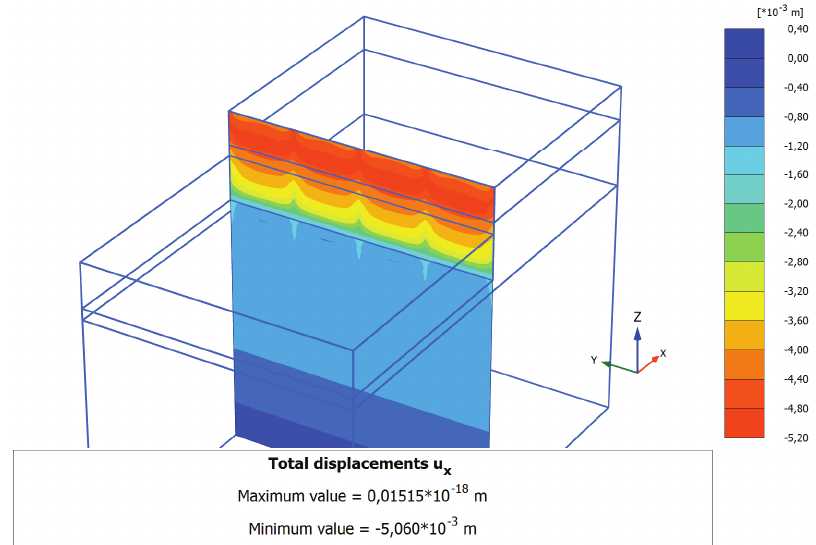
Fig. 12. Lagging displacements after the completion of the